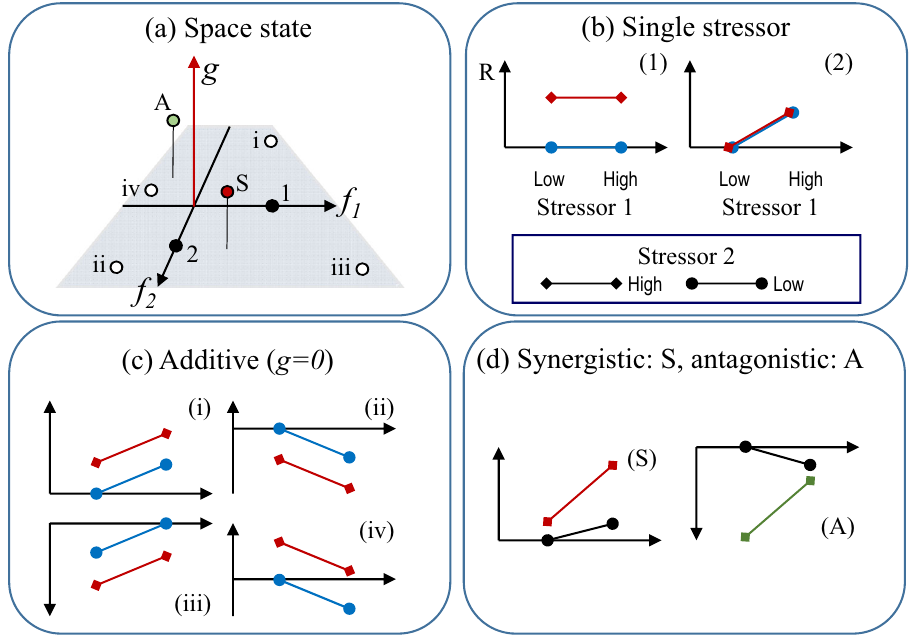
Fig. 2 The state-space representation and the mapping of selected types of multiple-driver responses into the state-space. a The state-space representation is based on plotting the response R ( a,b ) as its three components: isolated effect of driver 1: D 1 ( a ) = f 1 ; isolated effect of driver 2: D 2 ( b ) = f 2 ; combined driver effect: G ( a,b ) = g . Single driver responses shown in ( b ) are mapped in ( a ) on the axes f 1 and f 2 , respectively. Points corresponding to additive responses ( c ) lie on the plane de fi ned by f 1 and f 2 marked in grey; they are de fi ned as double positive (i), double negative (ii) and responses of different directions (iii and iv). d Selected interactive responses: synergistic for the double positive effect and antagonistic for the double negative. Other interactive responses (not shown) would be projected downwards (negative g value) or in the quadrants de fi ned by responses of different signs (either f 1 or f 2